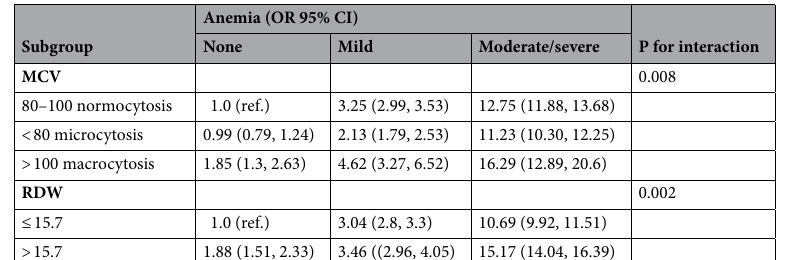
Table 2. Interaction between RDW, MCV and anemia associated with transfusion risk.